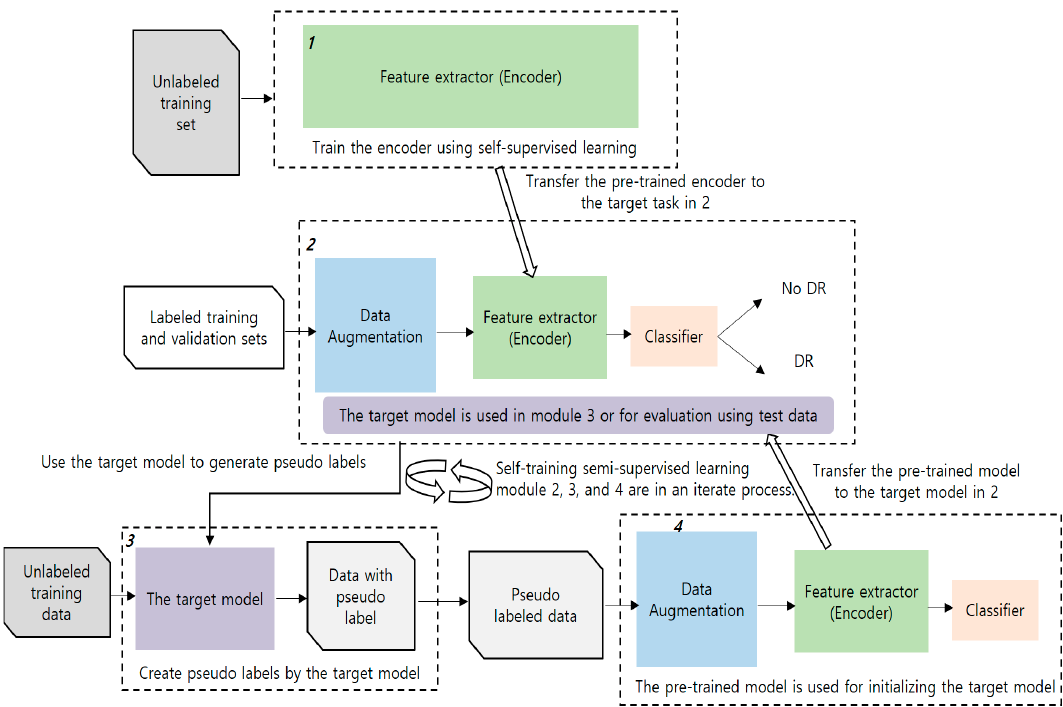
Figure 3. The framework of the proposed DR detection system.